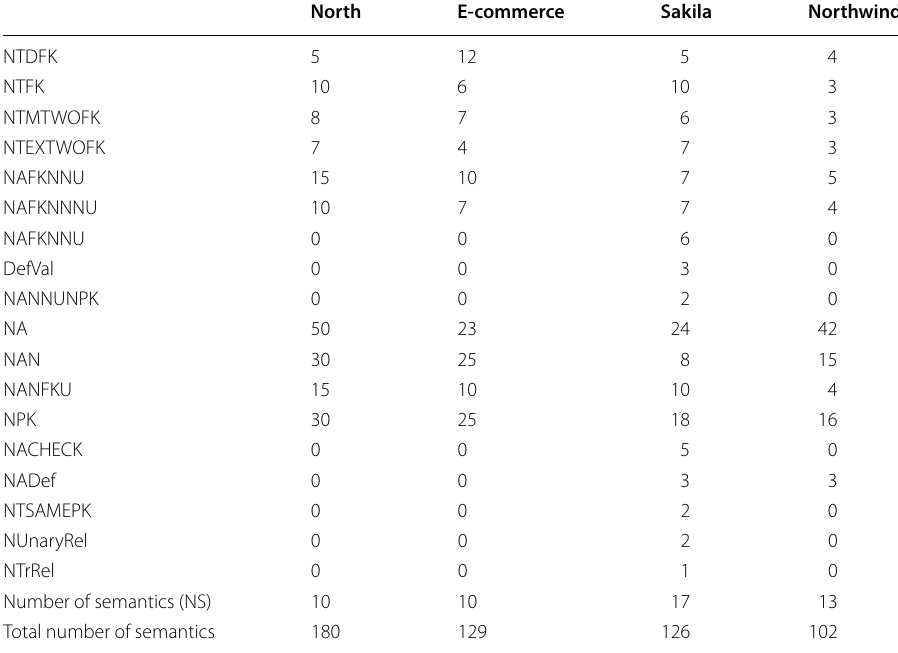
Table 7 The NS and the total number of semantics for each database